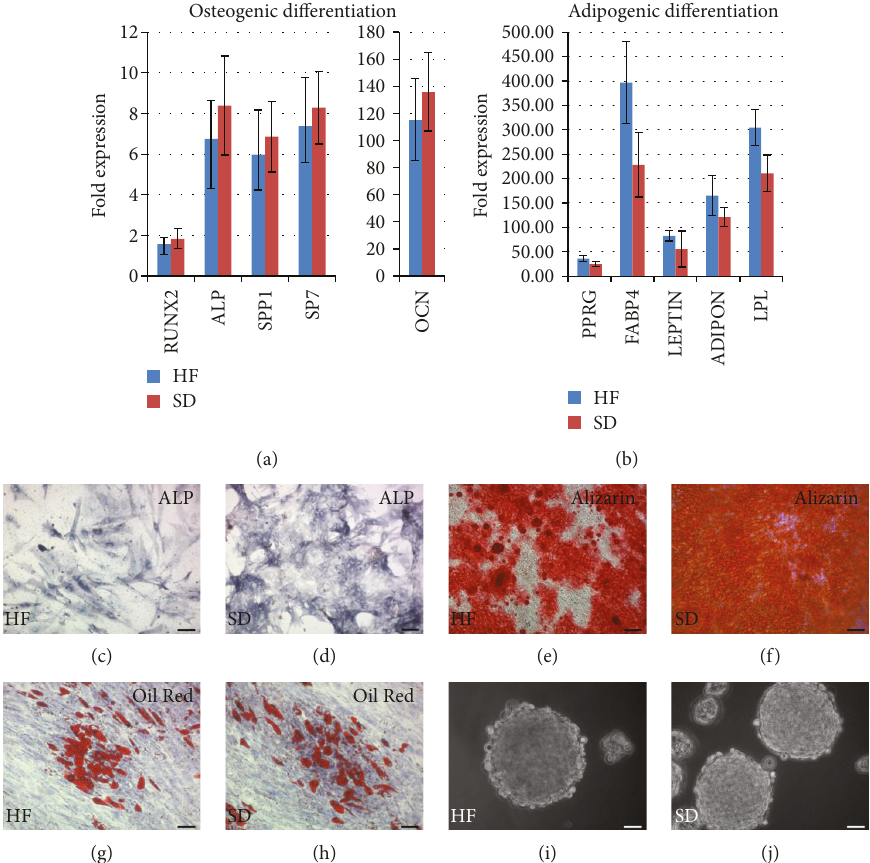
Figure 9: Mesenchymal di ff erentiation and neurosphere-like structure formation of HF (c, e, g, i) and SD NCSC cultures (d, f, h, j) at P3. (a) Osteogenic di ff erentiation, 14 days, qPCR analysis. (b) Adipogenic di ff erentiation, 14 days, qPCR analysis. The expression of all target genes was normalised to TBP gene expression levels and then to the undi ff erentiated control cells. The HF NCSC and SD NCSC cultures from fi ve donors were analysed. (c, d) Osteogenic di ff erentiation, 10 days, stain with BCIP ® /NBT Liquid Substrate System for ALP activity (dark blue). (e, f) Osteogenic di ff erentiation, 21 days, Alizarin Red S stain for mineralized extracellular matrix deposits (red). (g, h) Adipogenic di ff erentiation, Oil Red O stain for neutral lipid vacuoles (red) and Romanowsky-Giemsa counterstain. (i, j) Neurosphere-like structures, phase-contrast microscopy. (c – h) Scale bar: 100 μ m. (i, j) Scale bar: 50 μ